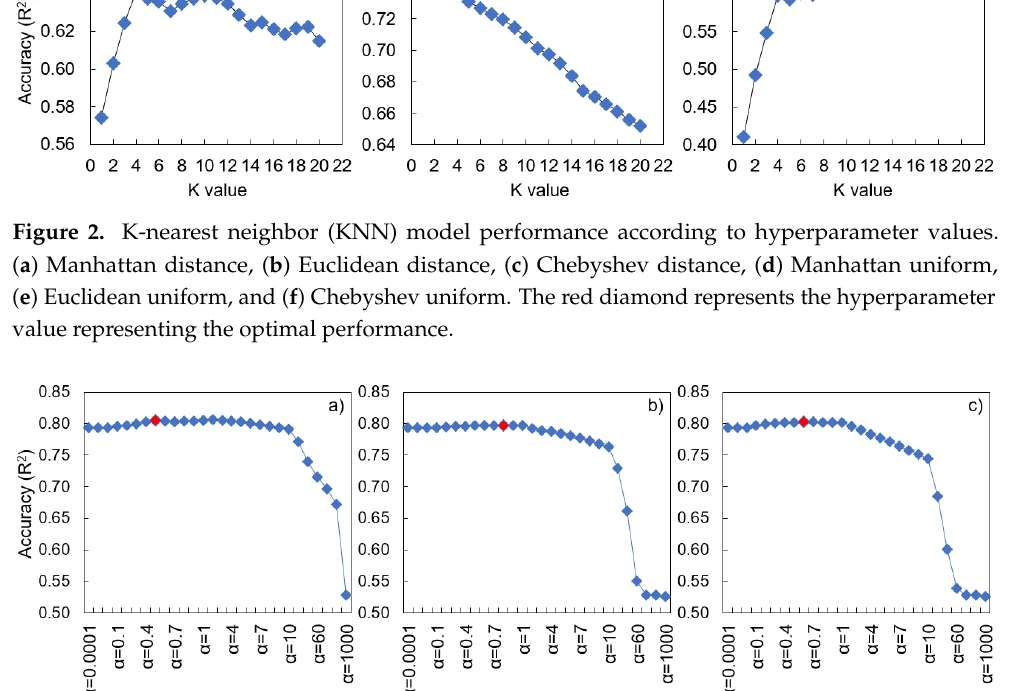
Figure 3. Linear regression model performance according to hyperparameter values. ( a ) Ridge, ( b ) Lasso, and ( c ) Elastic net regularization. The red diamond represents the hyperparameter value representing the optimal performance.